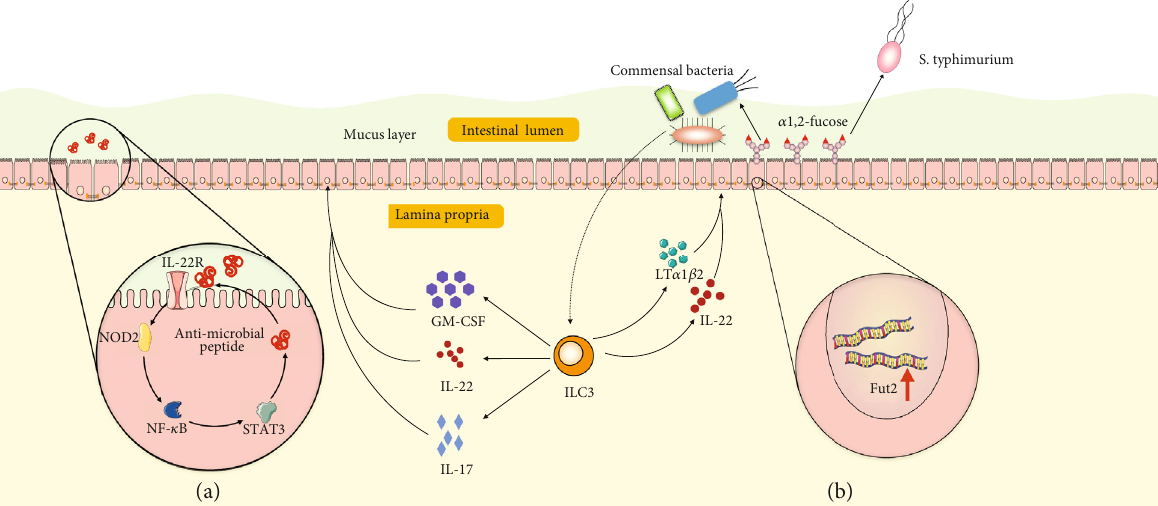
Figure 4: Illustration of epithelial cells and ILC3 interactions. (a) After bacterial infection, ILC3-derived GM-CSF, IL-22, and IL-17 stimulate epithelial cells by activating the IL-22R-NOD2-NF- κ B signaling pathway and result in epithelial cells secreting antimicrobial peptides into the mucus layer. (b) ILC3-derived IL-22 and lymphotoxin (LT α 1 β 2) induce fucosyltransferase 2 (Fut2) gene expression in epithelial cells and result in fucose production in the intestinal tract. Fucose can be utilized by commensal bacteria but not by pathological bacteria such as Salmonella typhimurium . ILC: innate lymphoid cell; GM-CSF: granulocyte-macrophage colony stimulating factor; NOD2: nucleotide oligomerization domain-containing protein 2; NF- κ B: nuclear factor- (NF-) κ B; STAT3: signal transducers and activators of transcription